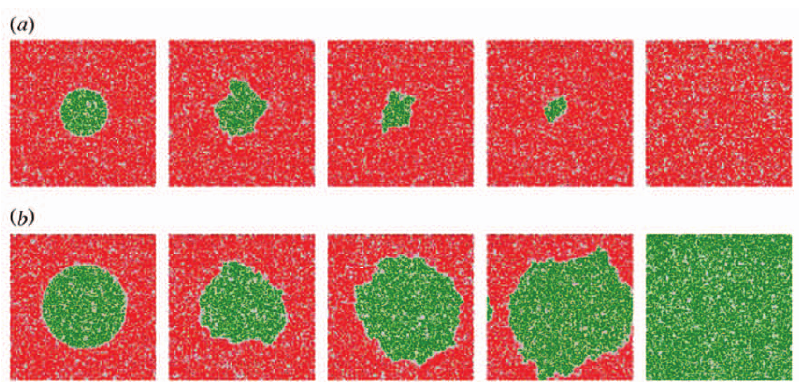
Figure 3. Stability of adhesion domains. (a) and (b): Time sequences of Monte Carlo snapshots of a membrane in the effective double-well potential of fig. 1(b) with rescaled depths u 1 ~ 0 : 125 and u 2 ~ 0 : 12 , rescaled width z we ~ 0 : 5 and rescaled separation z ba ~ 2 . Membrane patches bound in well 1 are indicated in green, and membrane patches bound in well 2 are red. In (a), the initial radius of the green domain bound in well 1 of the effective potential is below the critical radius for domain stability. Therefore, the domain shrinks and finally vanishes in the simulations. The shapshots are taken at times t ~ 0 , 2 : 10 4 , 7 : 10 4 , 8 : 10 4 , and 10 6 Monte Carlo steps per patch. In (b), the initial radius of the green domain is above the critical radius. The domain thus increases until the whole membrane is bound in the deeper potential well 1. The shapshots are taken at times t ~ 0 , 5 : 10 4 , 3 : 5 : 10 5 , 4 : 10 5 , and 10 6 Monte Carlo steps per patch.